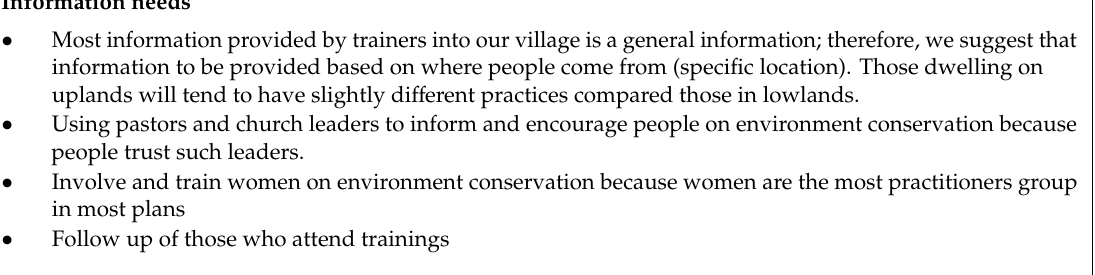
Table A2. Examples of information, resource, training and policy issues, as identified by communities. INFORMATION AND RESOURCES Information